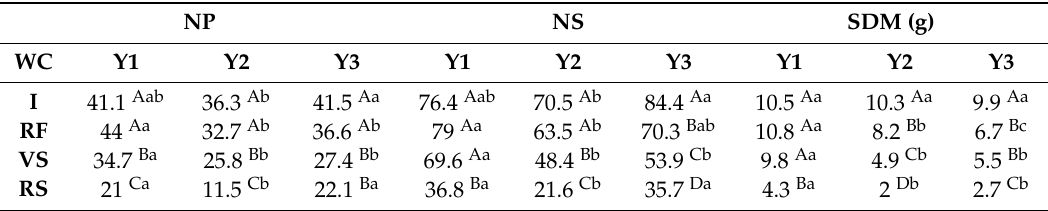
Table 3. Decomposition of the interaction water condition (WC) × agricultural year (Y) for total pod number (NP), total seed number (NS), and total seed dry weight (SDM) in soybean. Data shown represent the mean of four genotypes in Londrina, PR, Brazil.